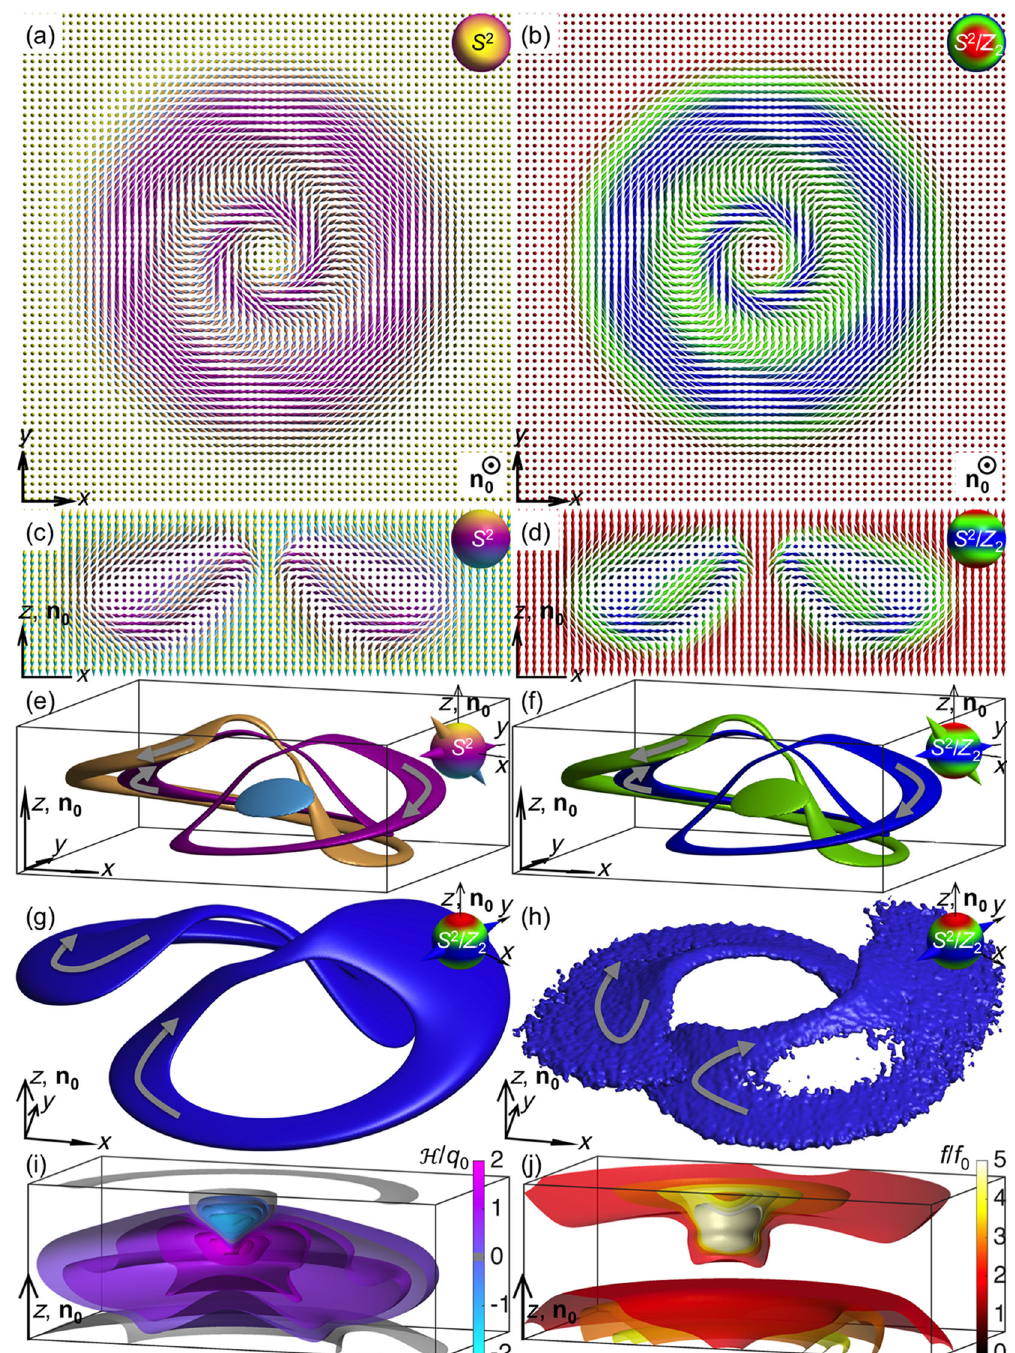
FIG. 2. 3D solitons with Q ¼ 0 . (a) – (d) Computer-simulated (a), (b) in-plane and (c), (d) vertical cross sections of n ð r Þ depicted using double cones and two different color schemes that establish correspondence between director orientations and the points on S 2 =Z 2 (top right insets). (e), (f) Computer-simulated preimages of a Q ¼ 0 3D soliton for two sets of the diametrically opposite points on S 2 =Z 2 marked by double cones in the top right insets for two different coloring schemes of the S 2 =Z 2 . (g), (h) Comparison of representative (g) computer-simulated and (h) experimental preimages of the Q ¼ 0 soliton for two diametrically opposite points on the “ equator ” of S 2 =Z – (h) indicate the consistently determined circulations of the preimages. (i), (j) Perspective 2 (top right insets). Gray arrows in (e) views of the 3D computer-simulated isosurfaces of normalized (i) handedness and (j) free-energy density for this axially symmetric solitonic structure, with the used color schemes provided in the right-hand side insets. The experimental preimages are reconstructed based on 3PEF-PM images obtained for structures in a 5CB-based partially polymerizable nematic LC mixture with chiral additive CB-15, d ¼ 10 μ m, and d=p ∼ 1 ; before imaging, the unpolymerized 5CB is replaced by immersion oil. Computer simulations are performed for 5CB elastic constants and assuming K 24 ¼ 0